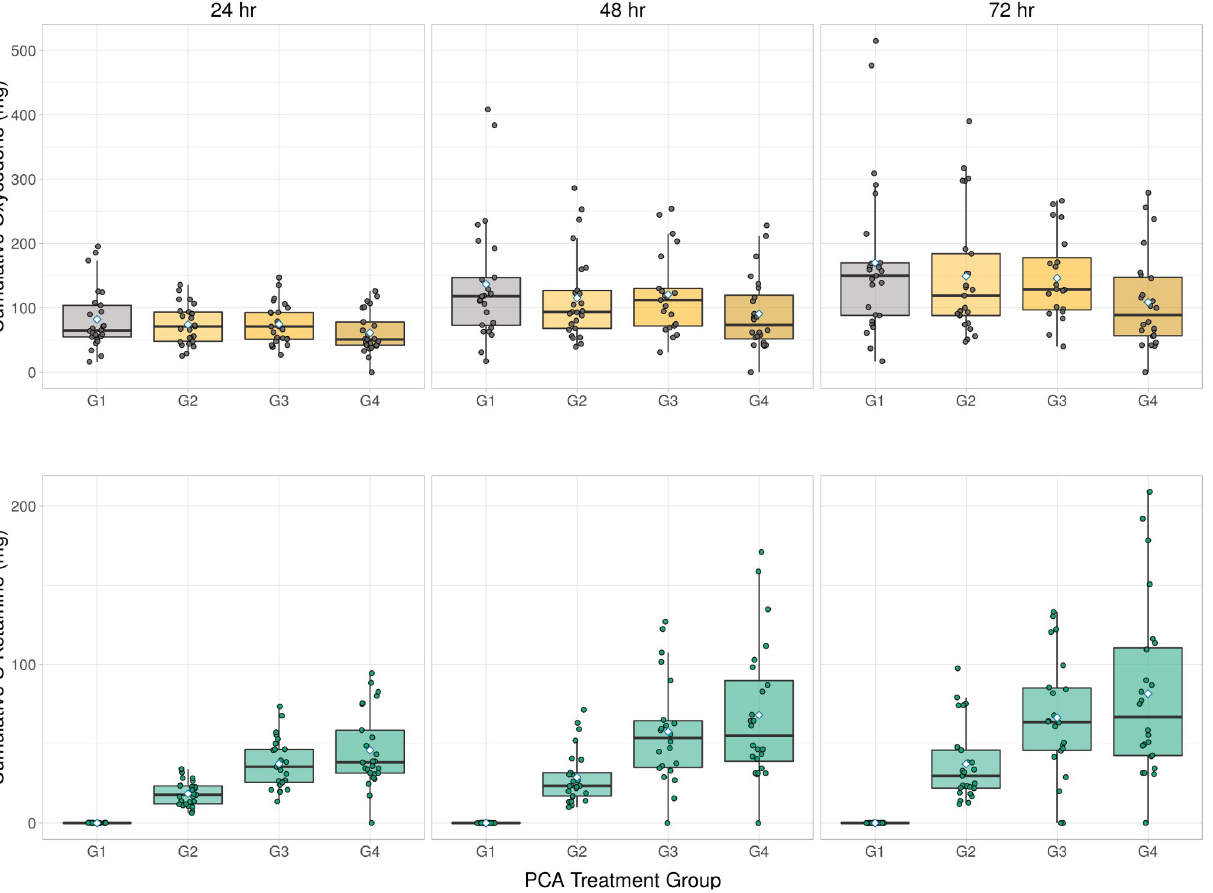
Fig 2. Postoperative cumulative oxycodone ( top row ) and S-ketamine ( bottom row ) consumption during the first 24 h in four patient-controlled analgesia (PCA) treatment groups (G1 ¬ –G4). PCA, patient-controlled analgesia. Box plots show the median and 25–75th percentiles, and the whiskers indicate the minimum and maximum. Blue diamonds show the mean oxycodone consumption in each plot.